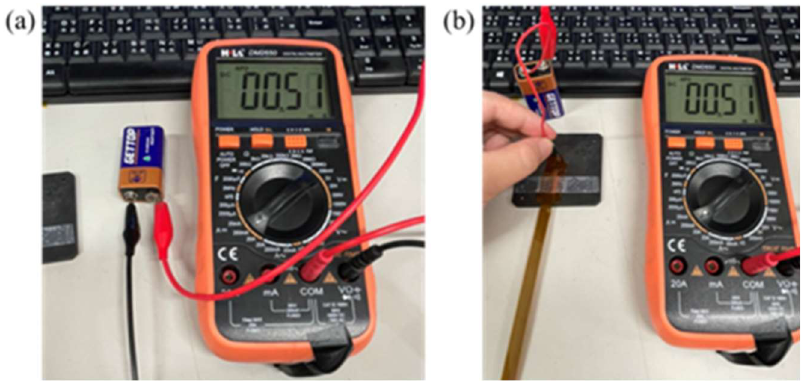
Figure 7. ( a ) Battery current measurement; ( b ) micro current sensor measurement cell.